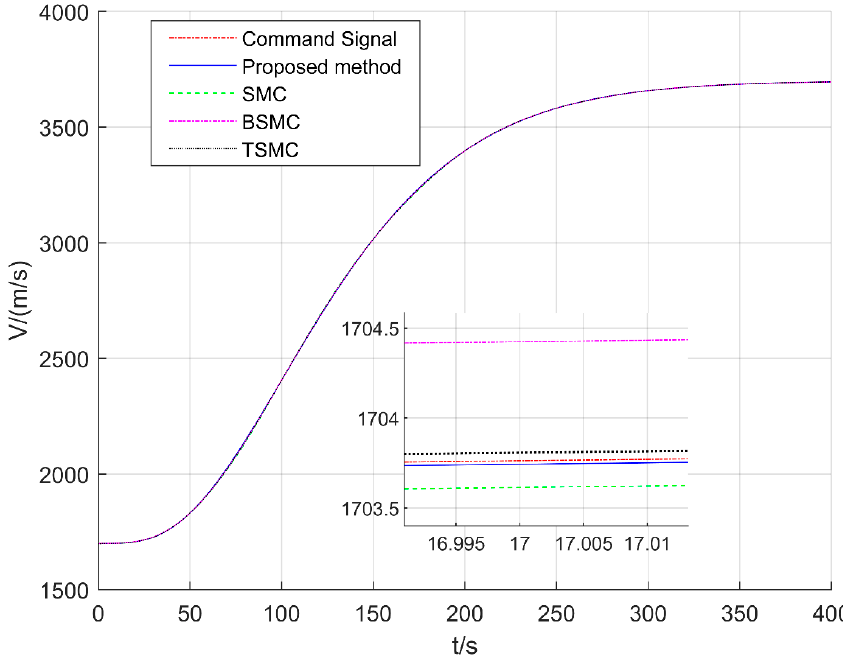
Figure 6. Responses of velocity tracking.